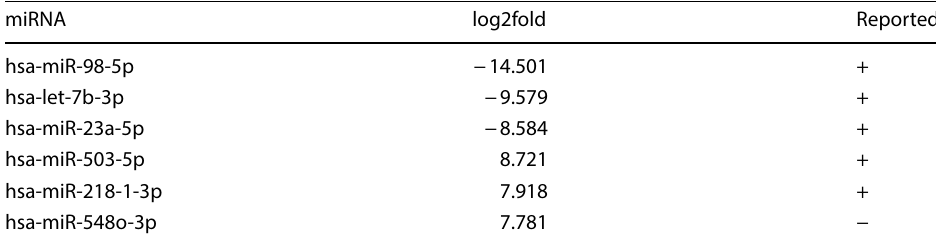
specified transcripts are not indicated in any cancer-related